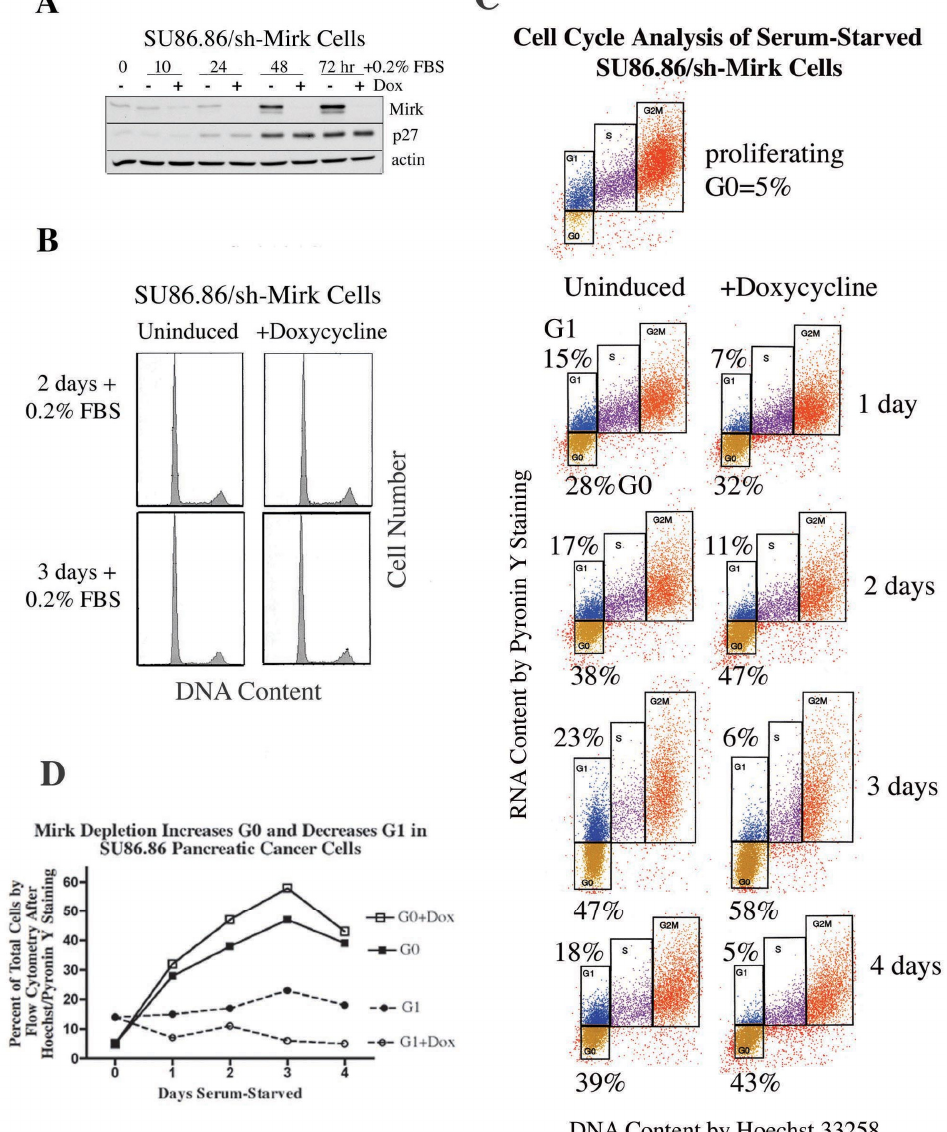
Figure 5. Serum-starved SU86.86 pancreatic cancer cells become quiescent in G0, and exhibit cell cycle modulations when depleted of Mirk. ( A ). Lentiviral stably transfected SU86.86/sh-Mirk pancreatic cancer cells expressing an inducible shRNA that targets the Mirk mRNA were cultured with doxycycline to induce the construct before Western blotting for Mirk, p27kip1 and actin. ( B ). Parallel cultures to panel A were analyzed by flow cytometry with propidium iodide staining. ( C ). Cell cycle position was determined by cytofluorography on ethanol-fixed SU86.86/sh-Mirk cells sequentially stained with Hoechst 33258 for DNA (x-axis) and then Pyronin Y (y-axis) for RNA. Cells were either proliferating in growth medium or serum-starved, shMirk induced by doxycycline as noted. G0 (gold, lower boxes) and G1 (blue, upper boxes) cells exhibit 2N DNA, with S phase cells (purple) and G2+M cells (orange). The flow cytometry data was performed on the same day under the same gating conditions. ( D ). Alterations in the fraction of cells in G0 and G1 with Mirk depletion. (Reprinted with permission from